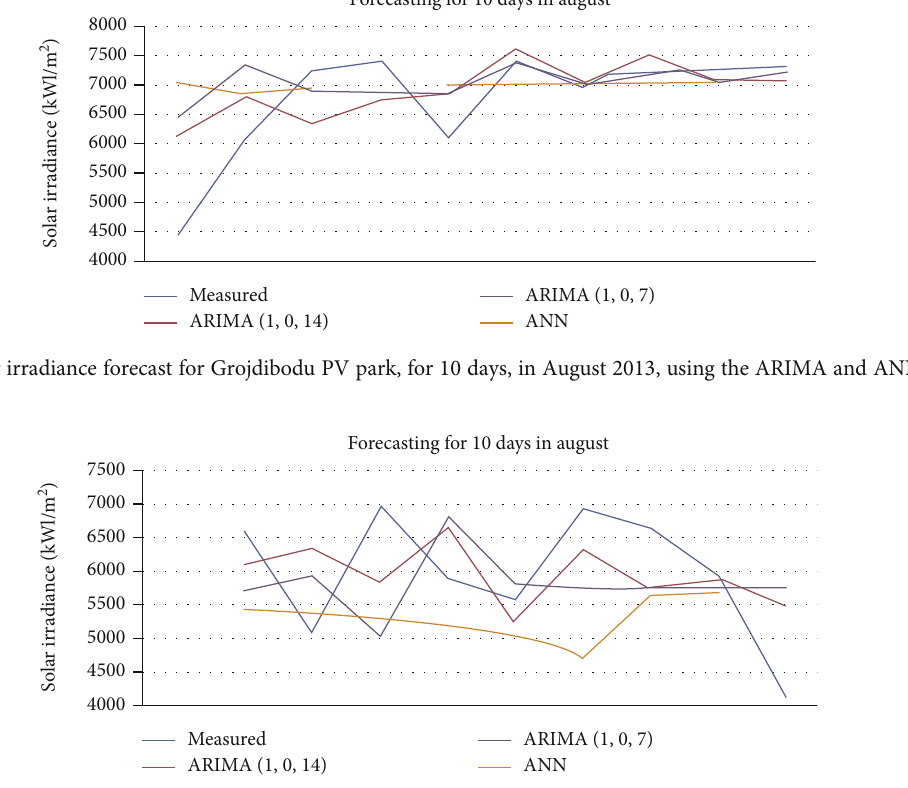
Figure 18: Solar irradiance forecast for Grojdibodu PV park, for 10 days, in September 2013, using the ARIMA and ANN models. Table 7: Measured and forecasted values for 10 days, August 2013, based on ARIMA and ANN models. This table is reproduced from [35] under the permission of the